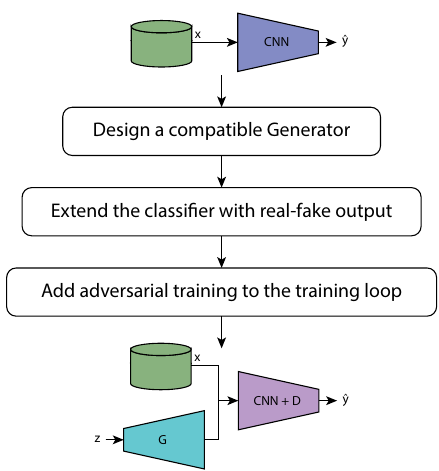
Figure 1. Simplified flowchart showing the basic steps of the proposed Generative enhancement methodology. The starting point is a network, which classifies training and testing samples x , assigning them a predicted label ˆ y . Using our methodology, the network is expanded to contain a generator ( G ), producing original training examples from a Gaussian noise input vector z .